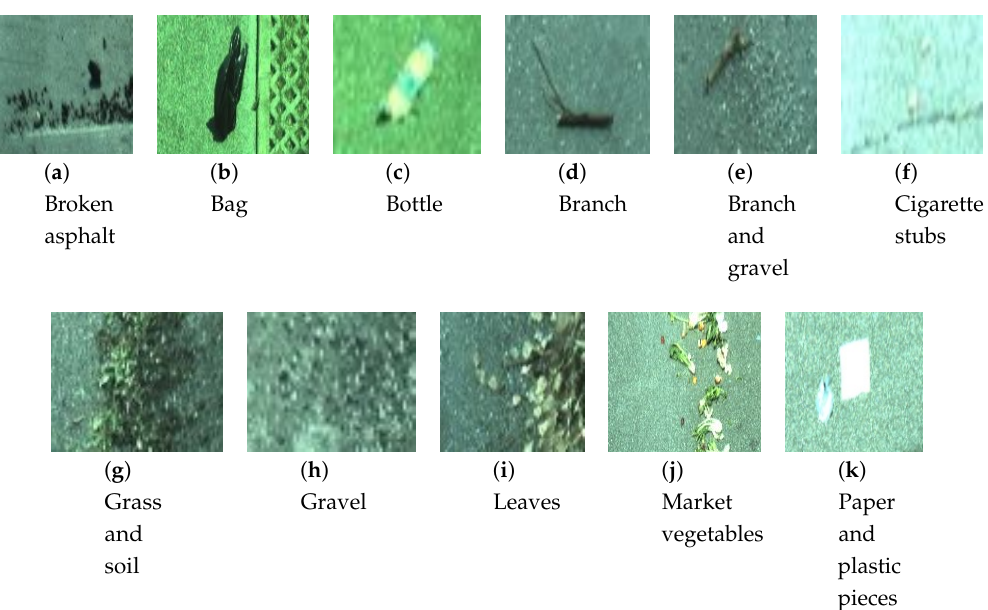
Figure 8. Some of the many backgrounds a road can exhibit (that we used in our training). They pose a great challenge for neural network generalization capabilities.